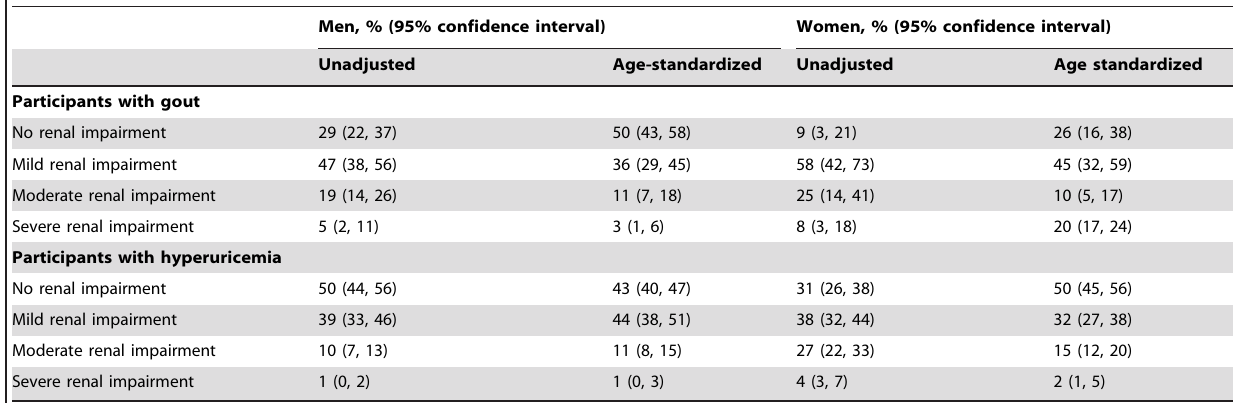
Table 5. Distribution of severity of renal impairment among people with gout and hyperuricemia. a